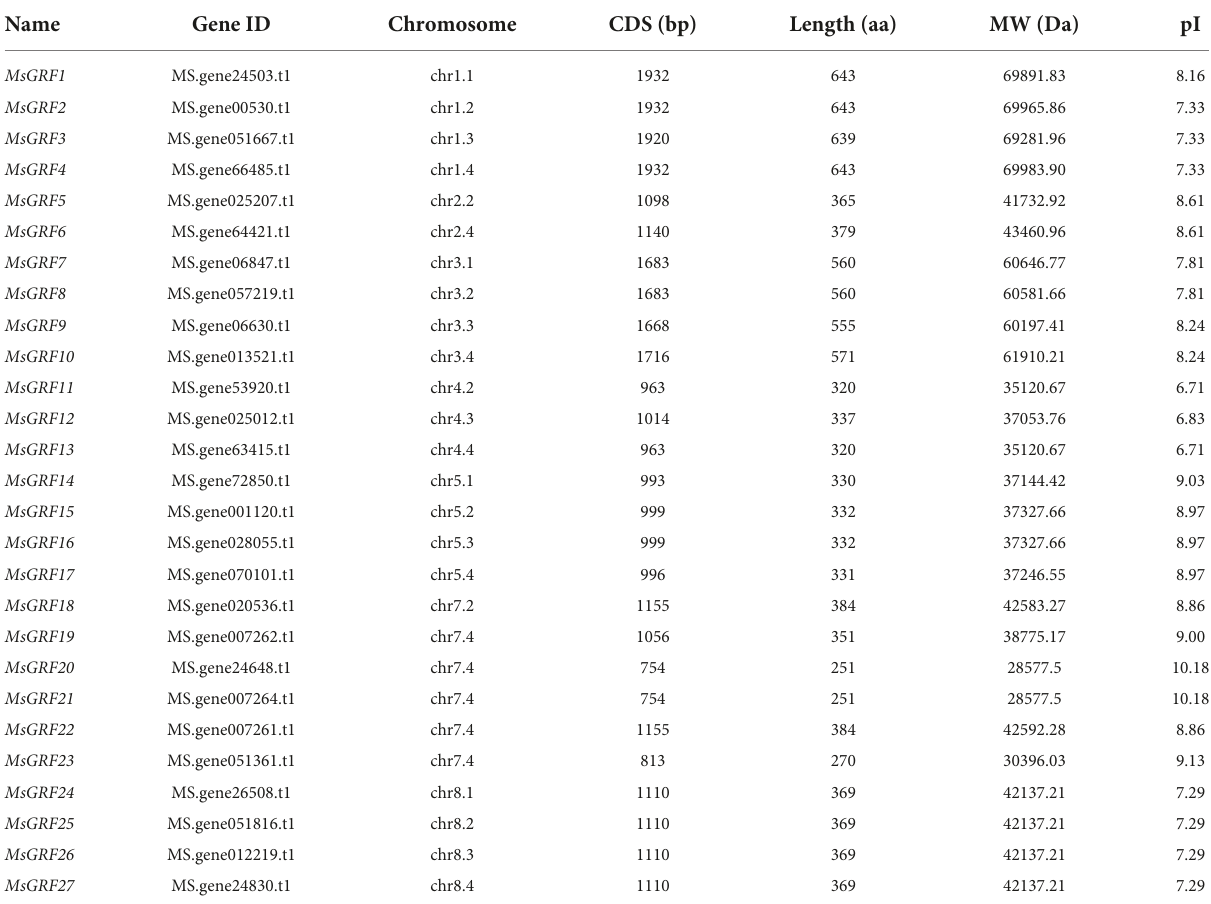
TABLE 1 Characterization of the MsGRF family in